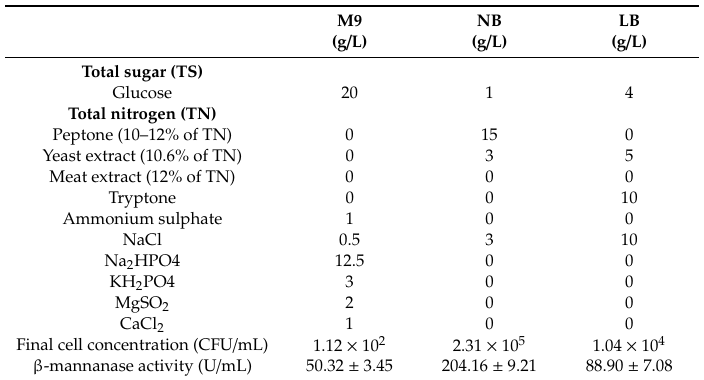
Table 1. Mean composition (g / L) and production of β -mannanase by B. subtilis ATCC 11,774 in commercial culture